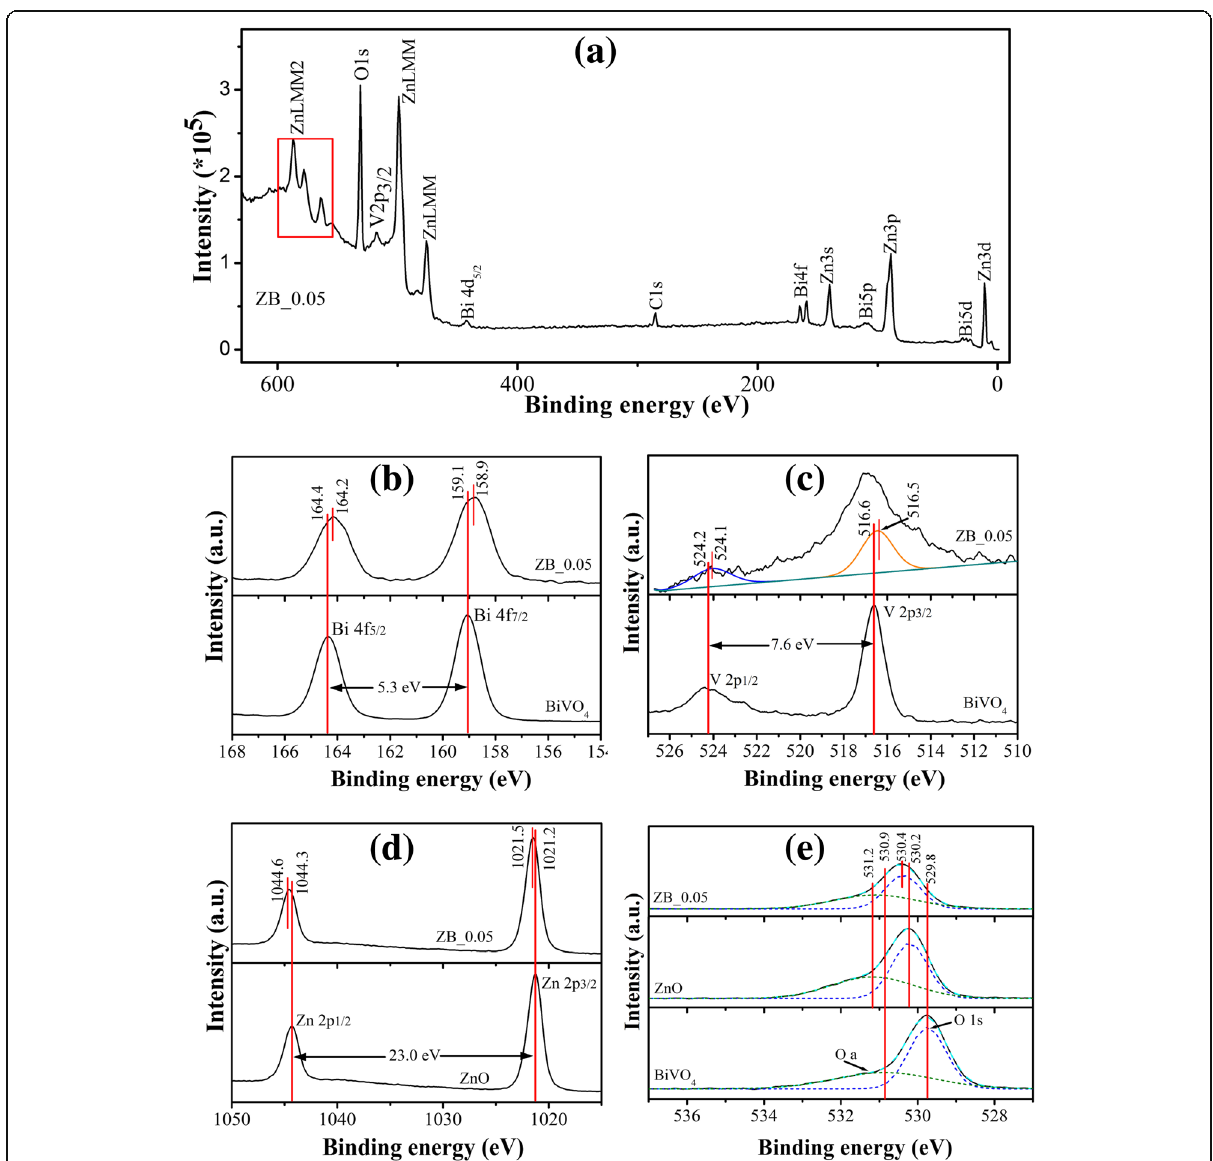
Fig. 4 XPS whole scanning spectrum of ZB_0.05 ( a ) and corresponding fine spectra of Bi 4f ( b ), V 2p ( c ), Zn 2p ( d ), and O 1 s ( e ) of ZnO, ZB_0.05, and